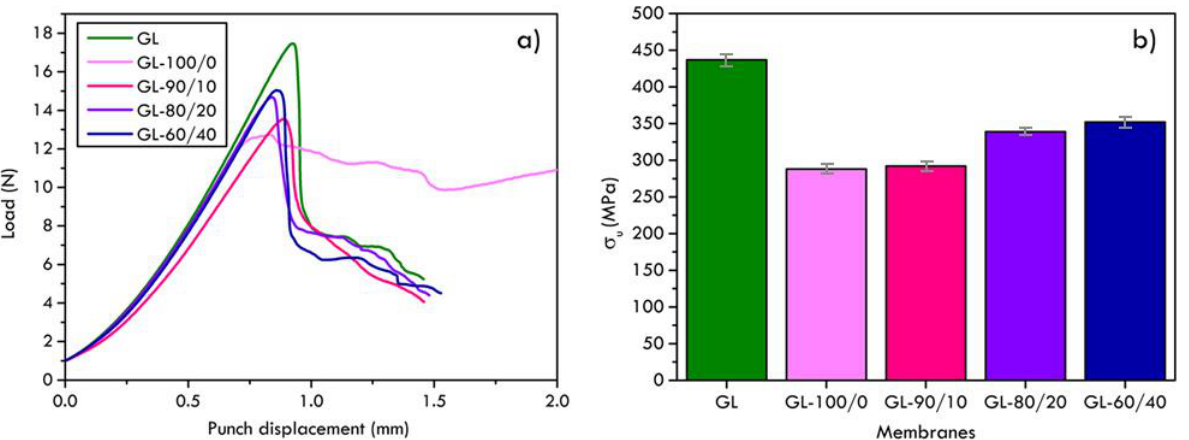
Figure 8. Force – displacement curves and ( a ) estimated values of the tensile strength ( b ) of pure graphite foils and tested samples.